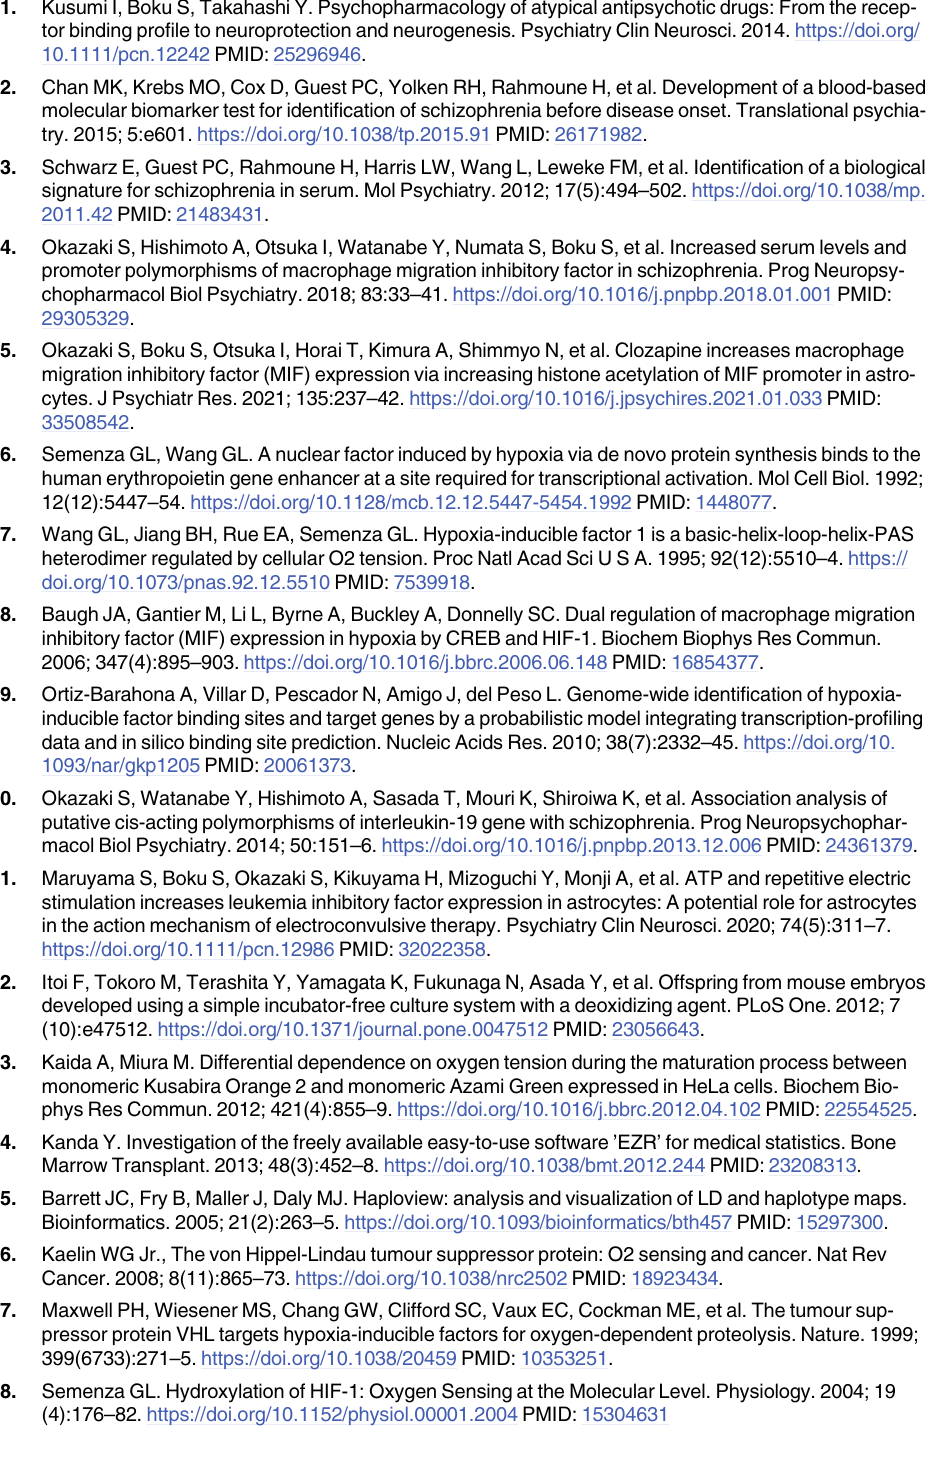
48. SemenzaGL. Hydroxylation of HIF-1: Oxygen Sensingat the MolecularLevel. Physiology. 2004; 19 (4):176–82. https://doi.org/10.1152/physiol.00001.2004PMID: